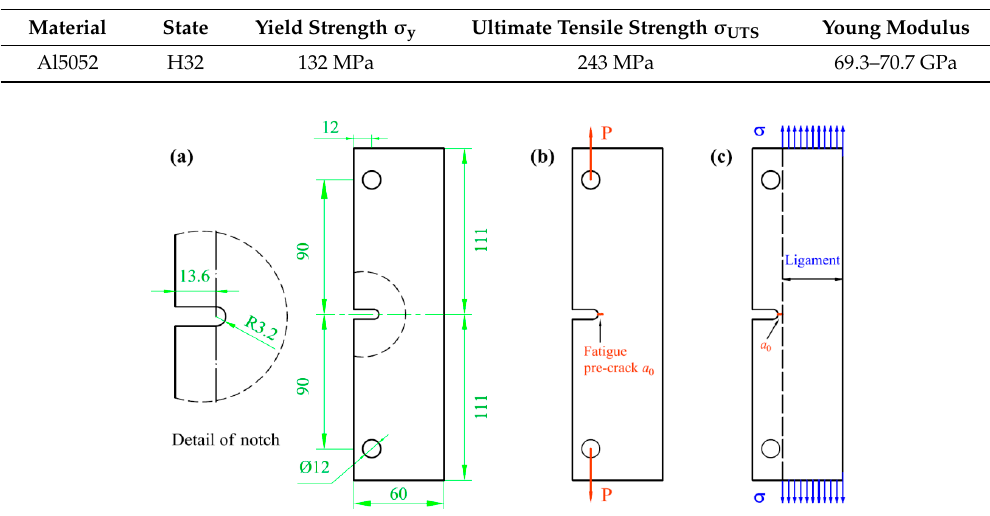
Table 1. The measured mechanical properties of 5052 Al alloy.